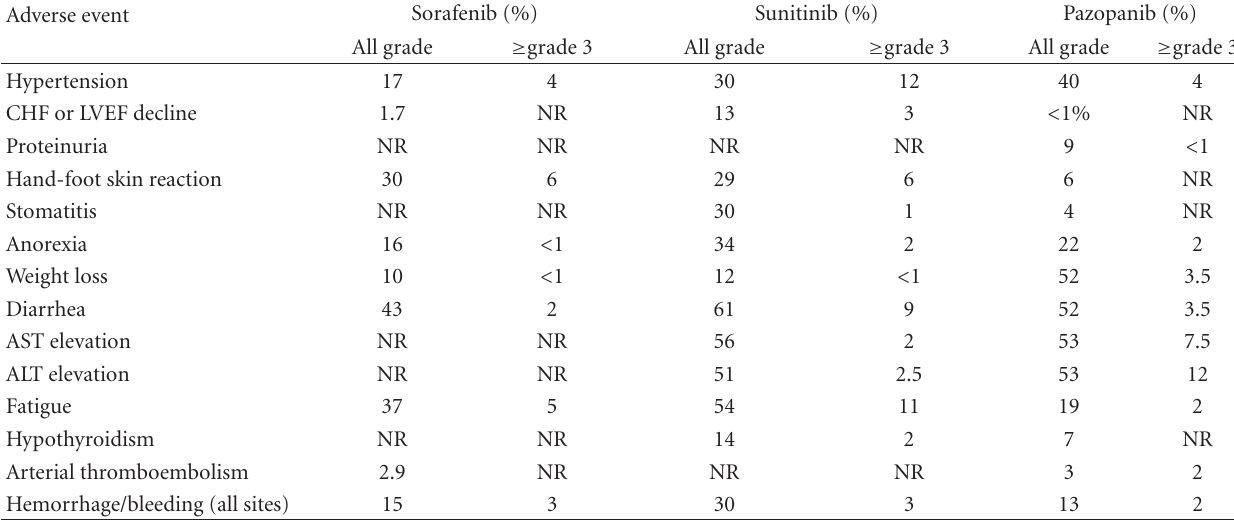
Hemorrhage/bleeding (all sites)